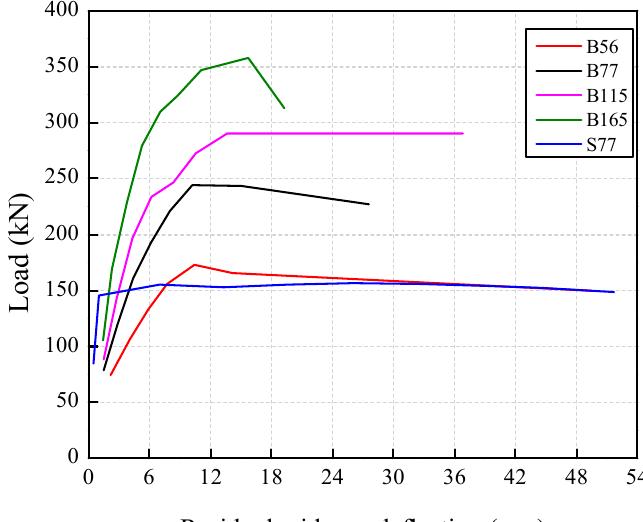
Figure 12. Residual deflection.